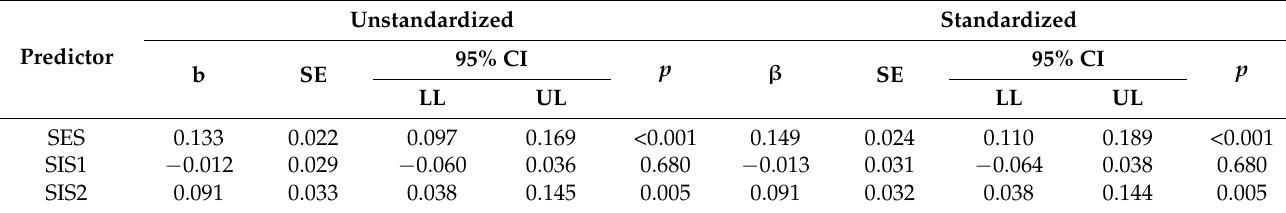
Table 2. Parameter estimates for a structural equation model where premature ejaculation was regressed on the original three factors of sexual excitation and inhibition.